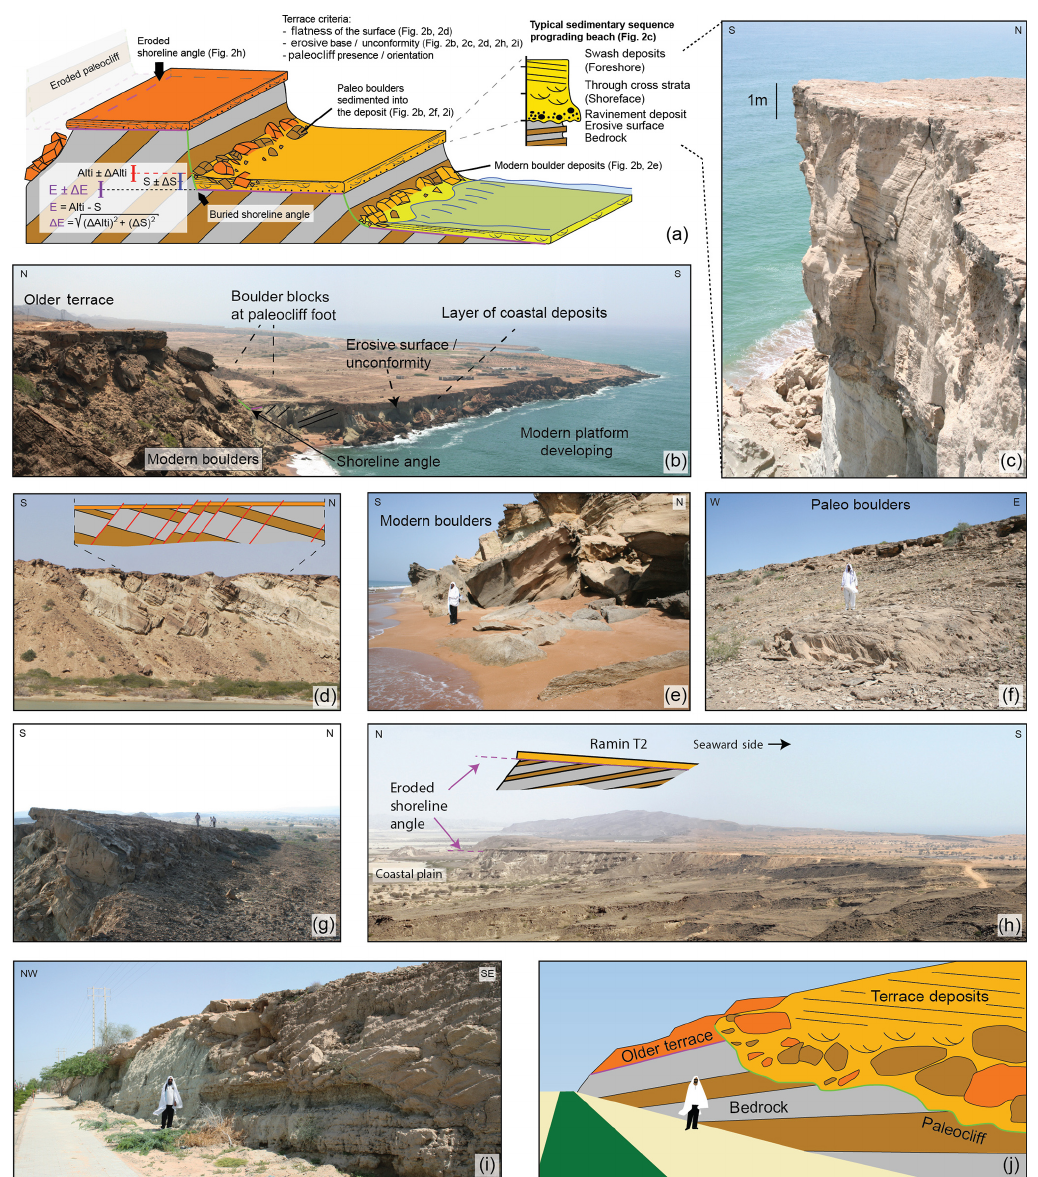
Figure 2. Pictures and sketches presenting the terrace geomorphology and sedimentology. Additional field pictures can be found in Normand et al. (2018). (a) Sketch of the general morphology of Makran terraces and the different criteria of recognition. Method used to calculate E ± (cid:49)E : Alti ± (cid:49) Alti is the altitude obtained from the DEM or the GPS measurement in the field, S ± (cid:49)S is the sediment thickness obtained from field observations, or we used 6 ± 4m as a general value when the real sediment thickness was not directly observed. (b) View of Lipar T1 (lower) and T3 (upper) (shot from 25.247924 ◦ N, 60.846619 ◦ E, looking southeast). We can see the waves carving the current terrace into both T1 and T3. Boulders of terrace deposits and bedrock origin are being sedimented within the beach deposits at the feet of the cliff. (c) Close-up of the terrace deposit of Lipar T2 (25.249823 ◦ N, 60.839074 ◦ E). The associated stratigraphic log is the number 1, reported in Fig. 4i. Notice the boulders at the base and the prograding sequence from shoreface to the foreshore parallel lamination at the top. (d) Outcrop at Lipar lake, showing numerous south-dipping normal faults crosscutting the tertiary bedrock and sometimes even the topping horizontal layer of terrace deposit (Ramin T1) (25.260840 ◦ N, 60.830019 ◦ E). (e) Modern boulders, i.e., boulders of bedrock and terrace deposit material being sedimented in modern beach deposits at the feet of the cliff (25.253043 ◦ N, 60.811024 ◦ E). (d) Their paleo equivalent, at 150m of altitude, now buried in cemented beach deposits (25.335013 ◦ N, 60.640952 ◦ E). Notice the sedimentary structures indicating that the boulder is tilted, similar to the modern boulders (rockfall). (g) Surficial expression of a northward-dipping normal fault, conjugate to those showed in Fig. 2d (25.258126 ◦ N, 60.824896 ◦ E). (h) View of the back of Ramin T2 and its eroded shoreline angle (shot from 25.286121 ◦ N, 60.769900 ◦ E, looking east). Notice the angular unconformity with the tertiary bedrock, which composes most of the foreground. The main surface visible on the right of the picture is Ramin T1. Lipar headland is visible in the background. (i) and (j) Road cut cross section through a paleocliff (25.332877 ◦ N, 60.621057 ◦ E). We can see the unconformity with the bedrock bedding (paleocliff – green line) and the rockfall boulders sedimented within the terrace